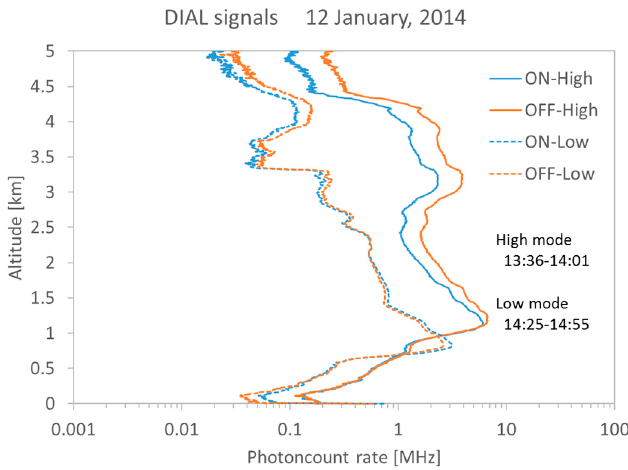
Figure 5. On-line and off-line return signals with high-altitude mode and low-altitude mode. The range resolution is 7.5 m.